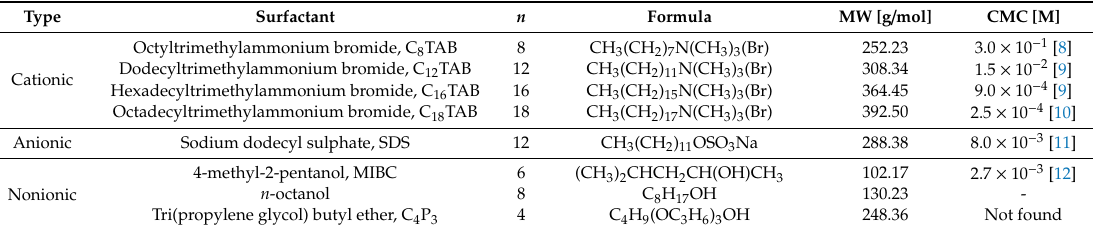
Table 1. Properties of ionic and non-ionic surface-active substances (SAS)